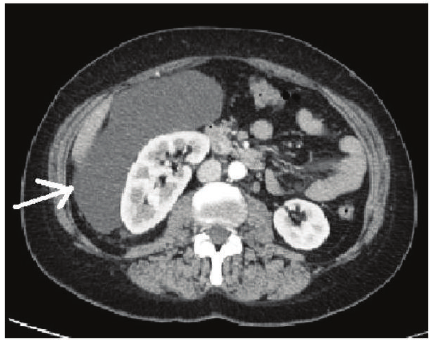
Figure 4: Microscopically, neoplastic mass consists of round to polyhedral cells, which had round, often eccentric nuclei and abundant eosinophilic granular and microvacuolated cytoplasm, myxoidareas,suggestingahistologicaldiagnosisofaretroperitoneal myxoid